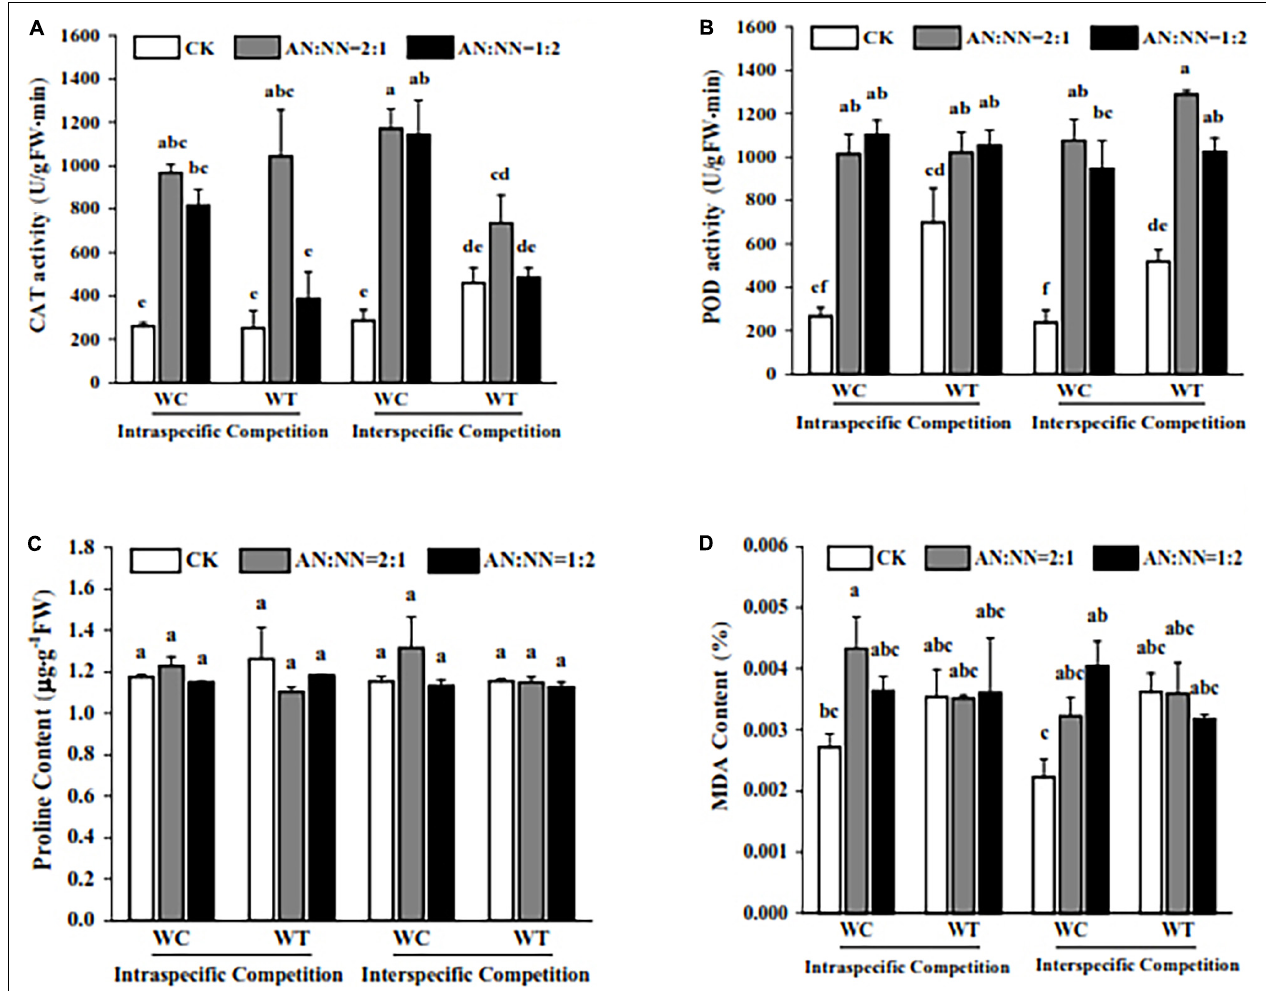
FIGURE 5 | Effect of different N forms and competitive treatments on plant antioxidant system under high N condition. WT, W. trilobata ; WC, W. chinensis ; CK, no nitrogen addition; AA, ammonium nitrogen; NN, nitrate nitrogen; N15(2:1), nitrogen form ratio AN:NN, 2:1 with total nitrogen amount of 15 g N · m − 2 · year − 1 ; N15(1:2), nitrogen form ratio AN:NN, 1:2 with total nitrogen amount of 15 g N · m − 2 · year − 1 ; (A) catalase activity; (B) peroxidase activity; (C) proline content; (D) malondialdehyde content (mean ± SE, n = 3). Different lowercase letters above bars indicate significant differences between different treatments ( p <